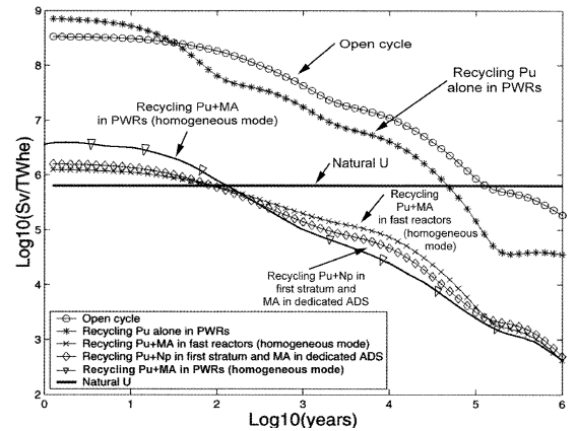
Figure 33. Radiotoxicity evolution with time for different scenarios of partitioning and transmutation. (Fig. 5 in [115]). Plutonium recycling alone reduces radiotoxicity by a factor of 3, but additional recycling of MA leads to about 300-fold reductions. © 2002 Elsevier, reproduced with